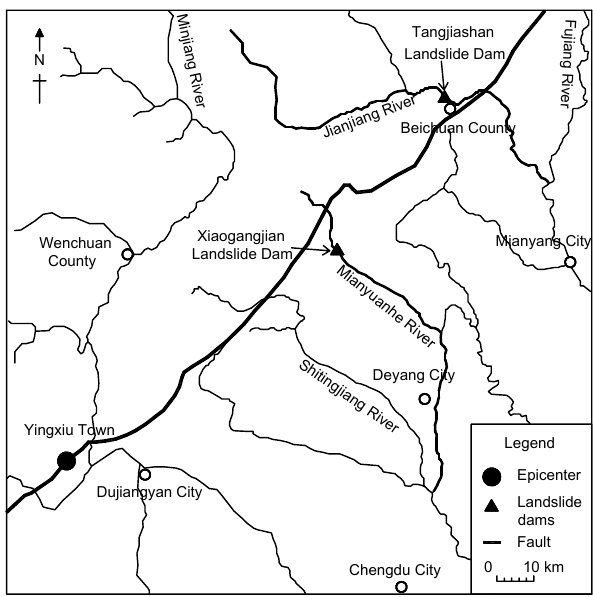
Fig. 4. Locations of the two investigated landslide dams.